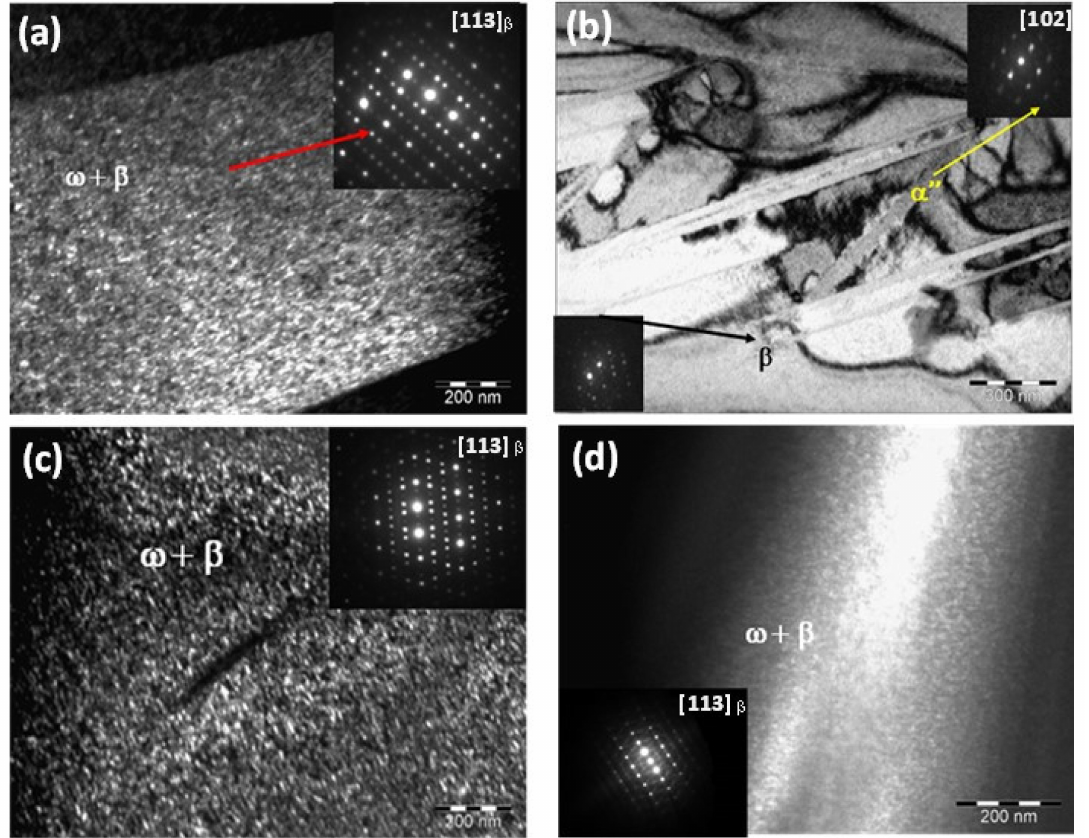
Figure 3. ( a ) TEM dark-field image of ω phase with an ellipsoidal morphology precipitated in a β matrix in the Ti–12Mo alloy and SAED pattern of β - and ω -Ti with the [113] β axis zone; ( b ) bright- field image of the martensitic α (cid:48)(cid:48) lamellae and SAED pattern of β and α (cid:48)(cid:48) phases in the Ti–12Mo alloy; ( c ) and ( d ) dark-field images of the ω precipitates with an ellipsoidal morphology in a β matrix in the Ti–12Mo–3Nb and Ti–12Mo–20Nb alloys, respectively.